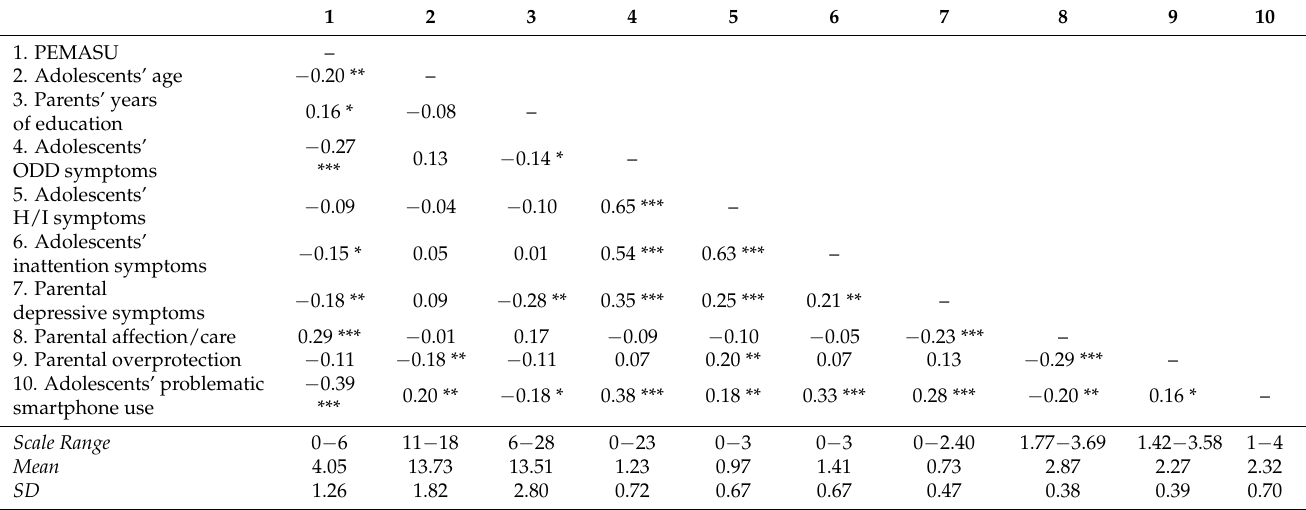
Table 1. Bivariate Correlations, Means, and Standard Deviations for the Variables.